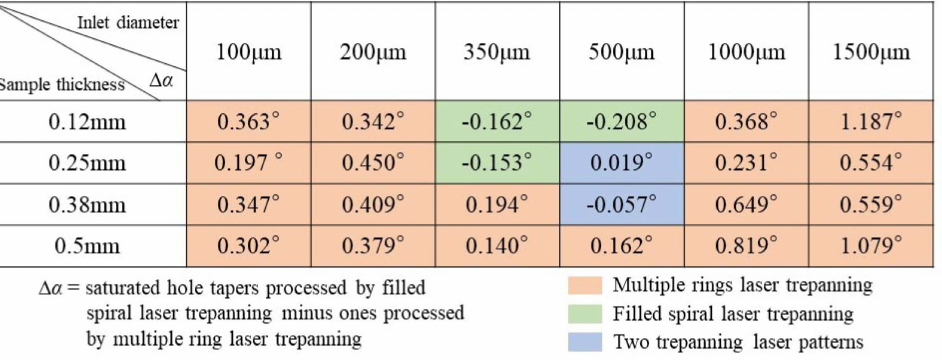
Figure 7. Optimization of trepanning patterns for hole quality based on the hole saturated tapers.